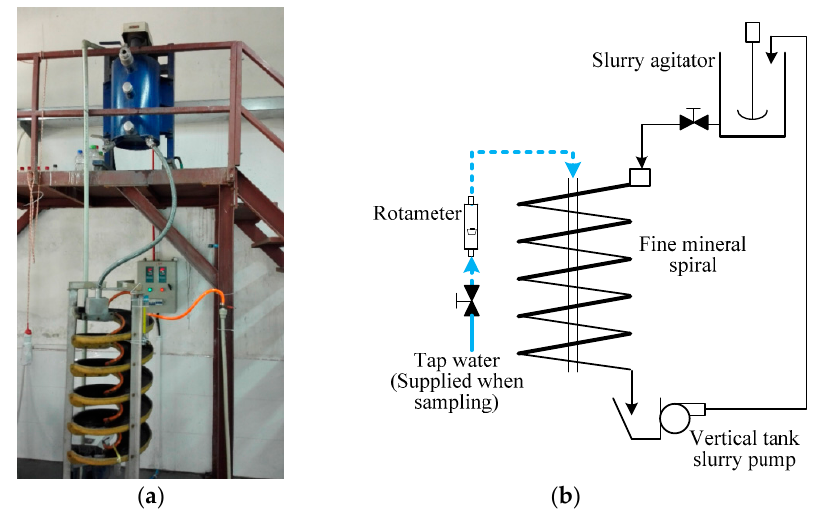
Figure 4 . ( a ) Recirculating spiral and ( b ) its schematic set-up.